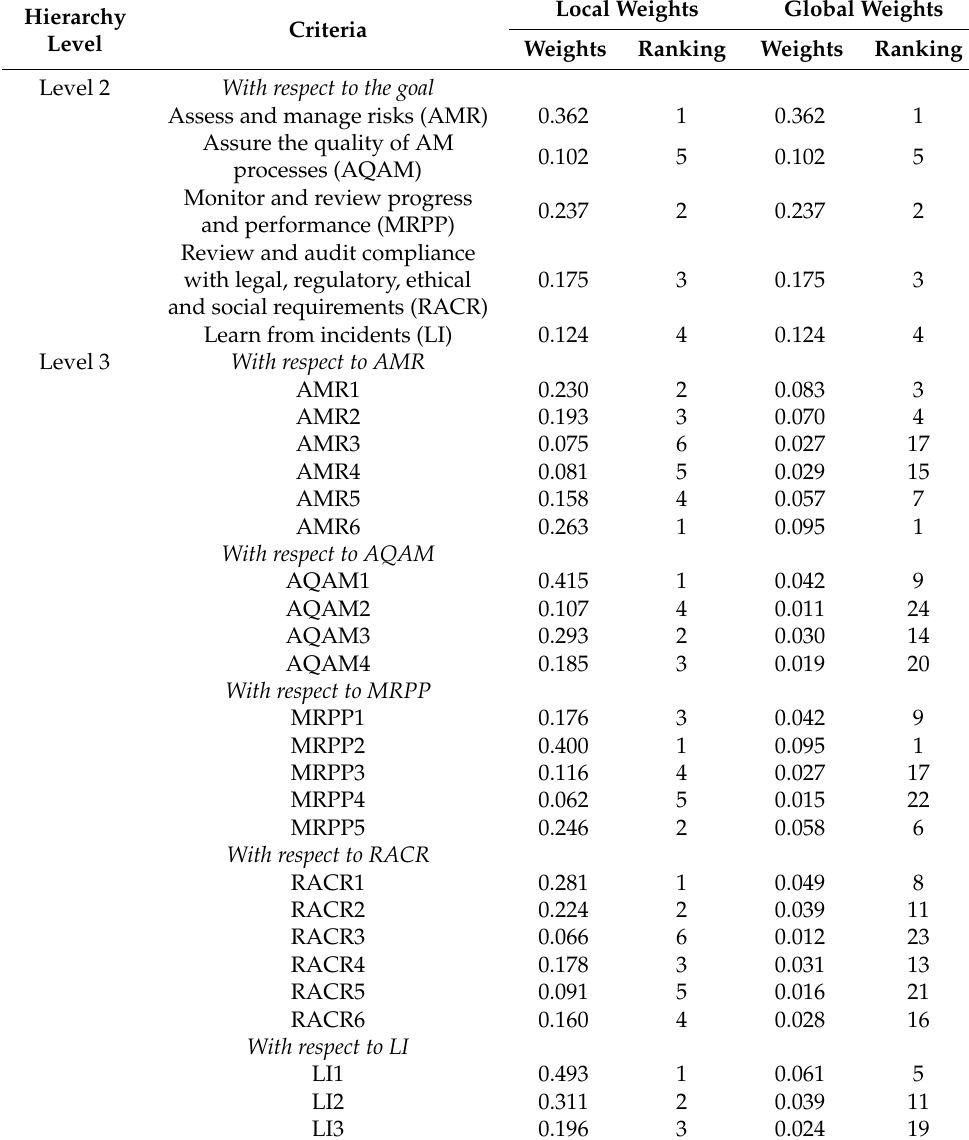
Table 10. The local and global